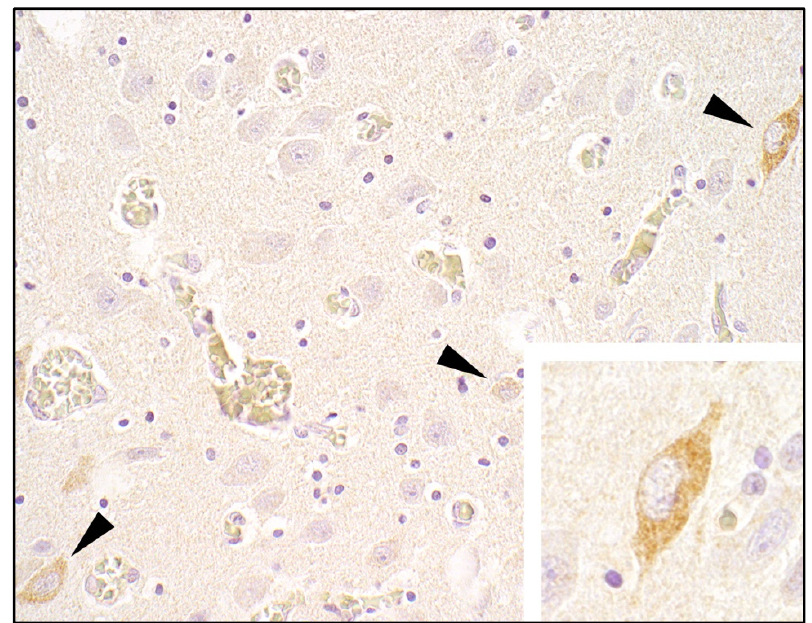
Figure 3. Detection of LindaV by immunohistochemistry in the cytoplasm of neurons (arrowheads) in the brainstem of a CT piglet. Primary antibody: pestivirus E2-specific monoclonal antibody 6A5; counterstain: hematoxylin, magnification 400 × , insert 600 ×